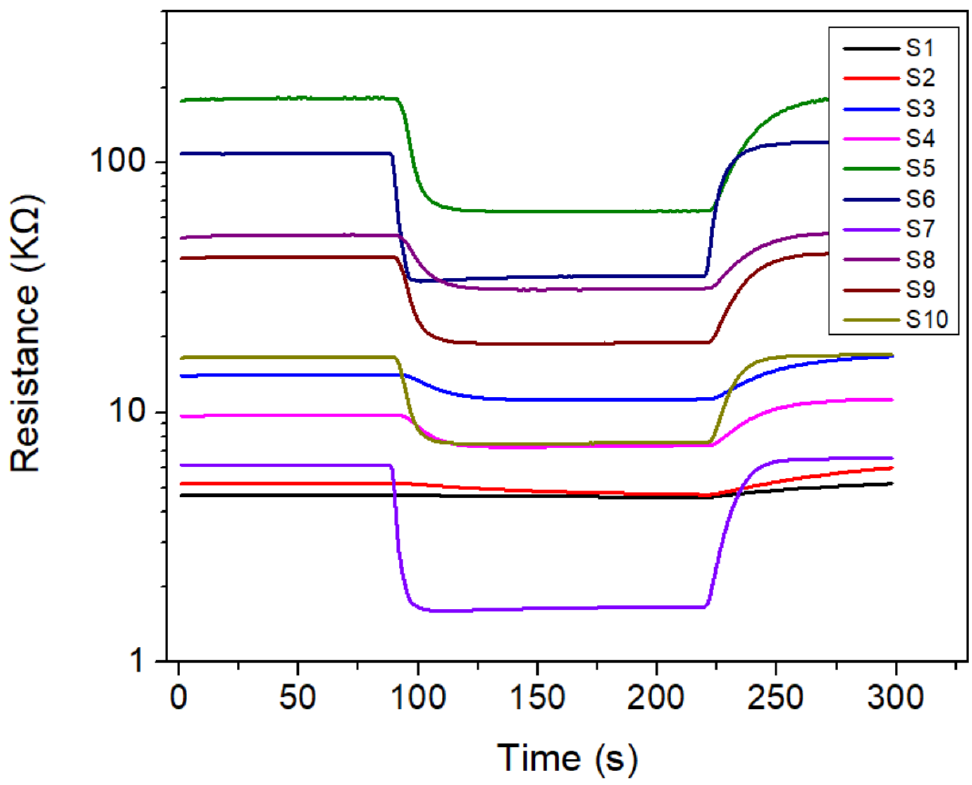
Figure 2. Typical response curves of initial sensor array in CO-CH 4 gas mixtures.